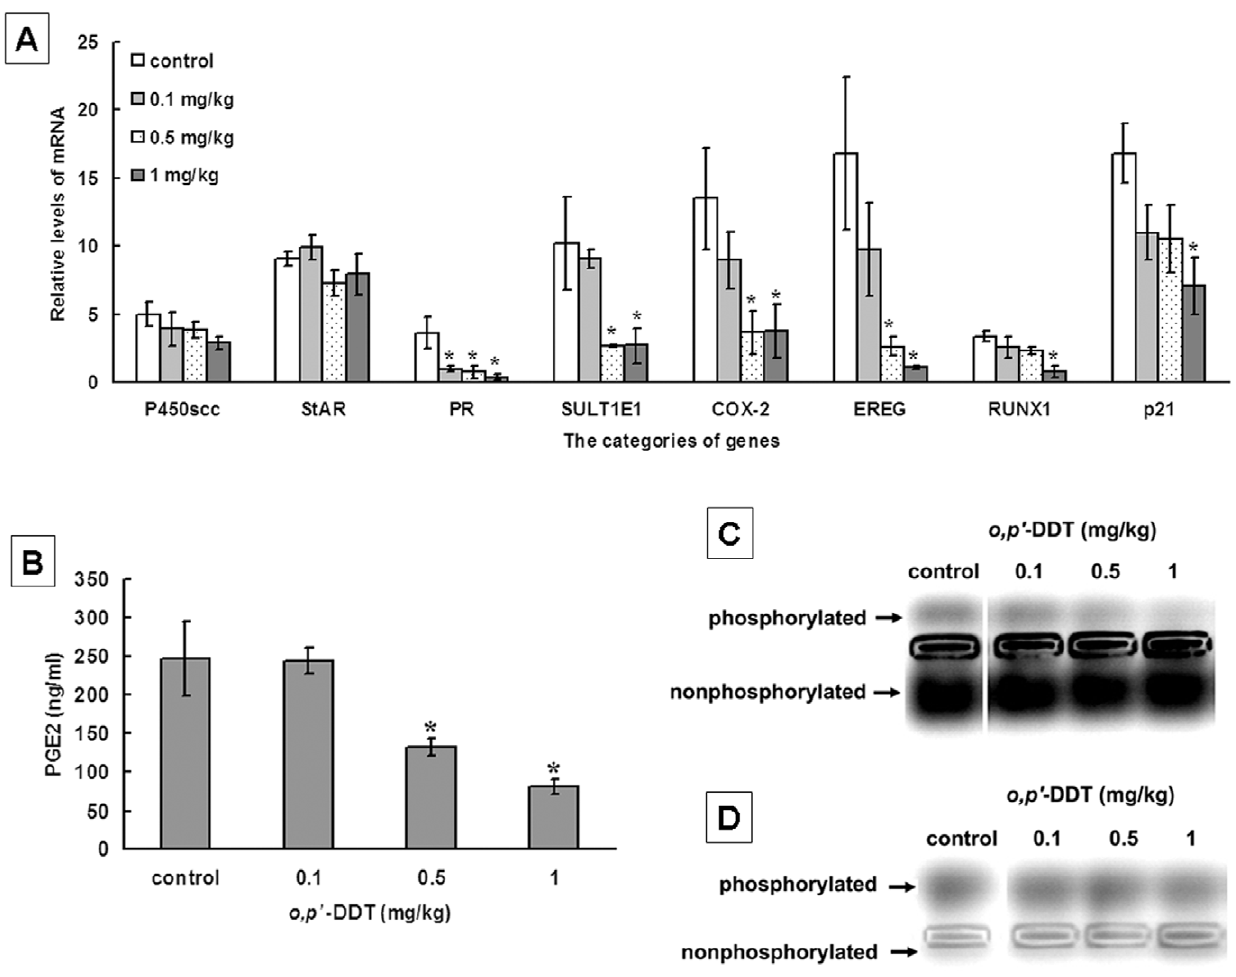
Figure 4. Low doses of o,p’ -DDT affect the invivo expression of genes, PGE2 secretion and PKA activity in rat ovaries. Female rats were received daily i.p. injections of o,p’ -DDT at doses of 0.1, 0.5, 1 mg/kg/day for 6 days. Ovaries were collected to isolate the granulosa cells. ( A ) In vivo expression levels of mRNA for ovarian genes. ( B ) Levels of PGE2 in rat ovarian tissues. ( C ) In vivo PKA activity (phosphorylated band) in rat ovarian tissues. ( D ) In vivo PKC activity (phosphorylated band) in rat ovarian tissues. The results of ( A ) and ( B ) were shown as mean 6 SEM for three independent experiments performed in triplicate. The data of ( C ) and ( D ) represented similar results from three independent experiments. *, r , 0.05, compared to